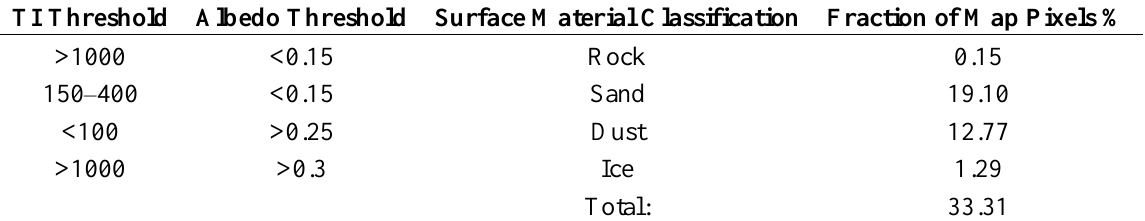
Table 2. Values of thermal inertia (TI) and albedo that would result in an unambiguous interpretation of surface